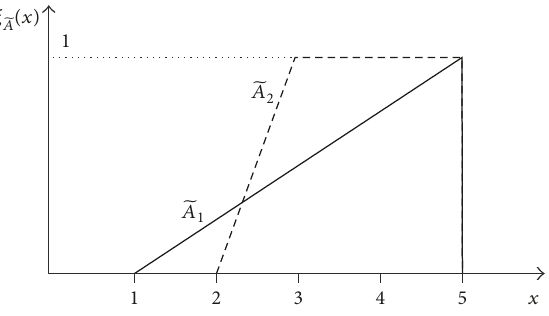
̃𝐴 ̃𝐴 1 and 2 in Example 18.